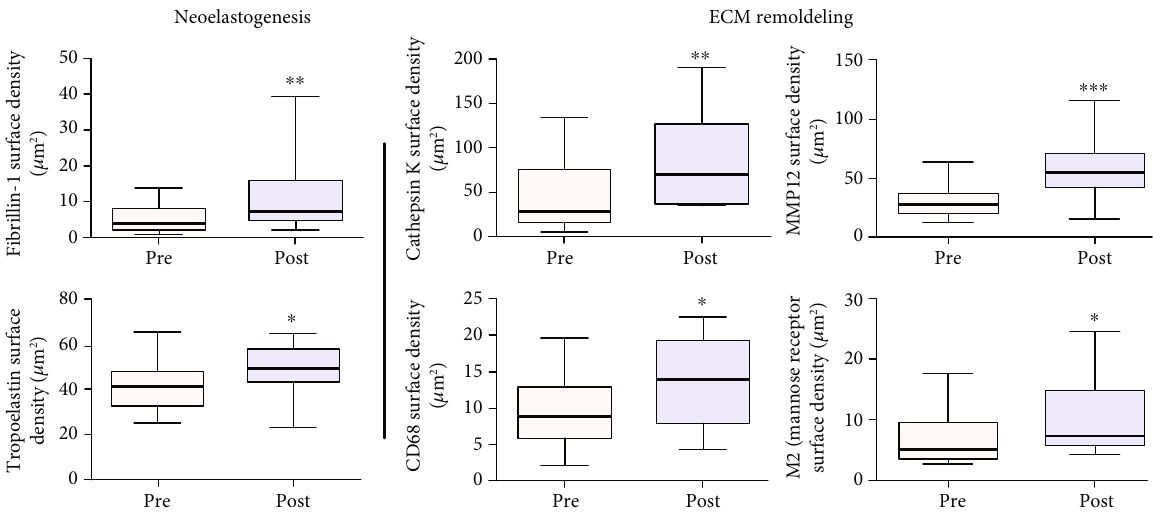
Figure 8: Immunohistochemical analysis after ADSC skin therapy into two aspects: neoelastogenesis represented by anti- fi brillin immune labelling that showed overall increase of fi brillin, including in the zone 1 ( p = 0 : 001 ), and anti-tropoelastin immune labelling that showed increase of the tropoelastin reactive material in the post treatment biopsy ( p < 0 : 05 ). Extracellular matrix (ECM) remodeling was represented by anti-cathepsin K immunostaining that revealed an increase in quantity of CAT-K immune-labelled cells in the dermis of a posttreated skin biopsy ( p = 0 : 011 ), anti-MMP12 immunostaining representation of percentage of MMP12 in the skin biopsies signi fi cantly increased after ADSC treatment ( p = 0 : 005 ), anti-CD68 and CD206 (mannose receptor (MR)) macrophage immunostaining in sun-exposed facial skin before and after ADSC injection that showed a signi fi cant increase after ADSC treatment in the dermis of posttreated skin biopsy ( p < 0 : 05